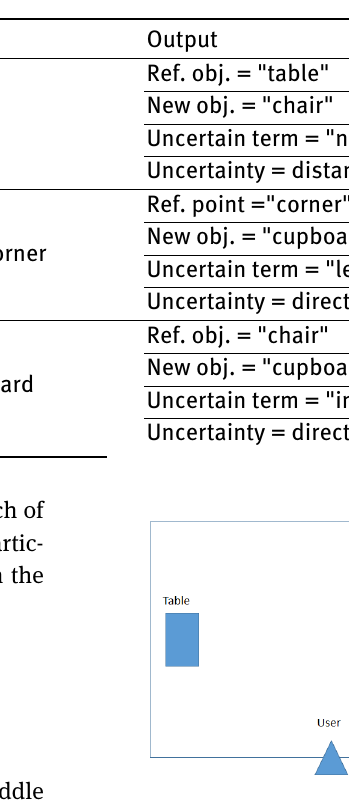
Table 1: Example sentences and outputs.